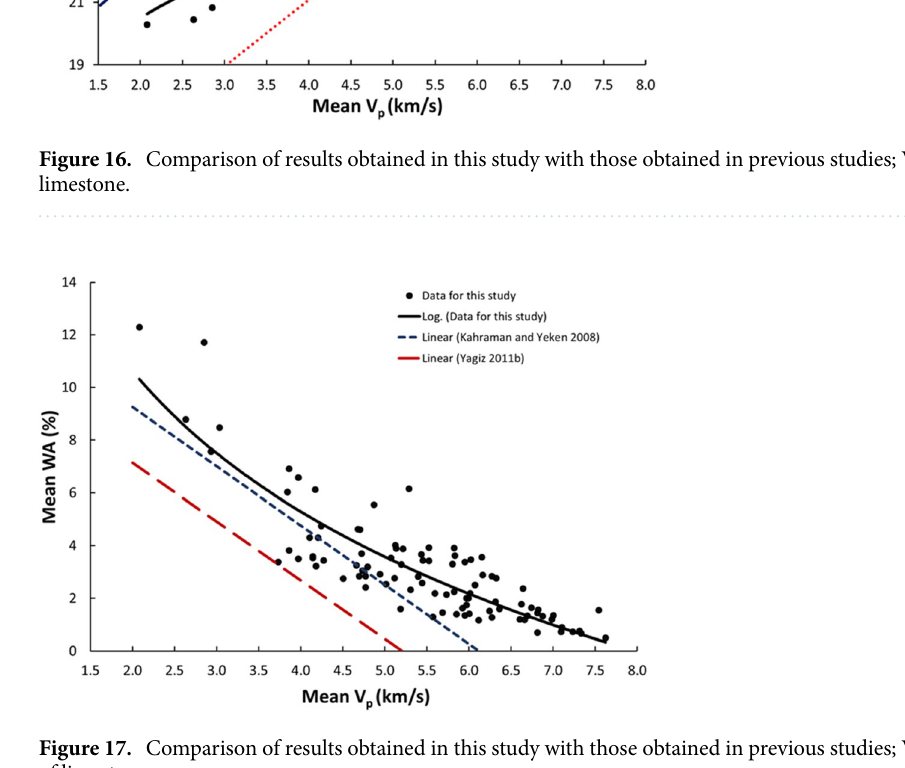
Figure 17. Comparison of results obtained in this study with those obtained in previous studies; V p versus WA of limestone.